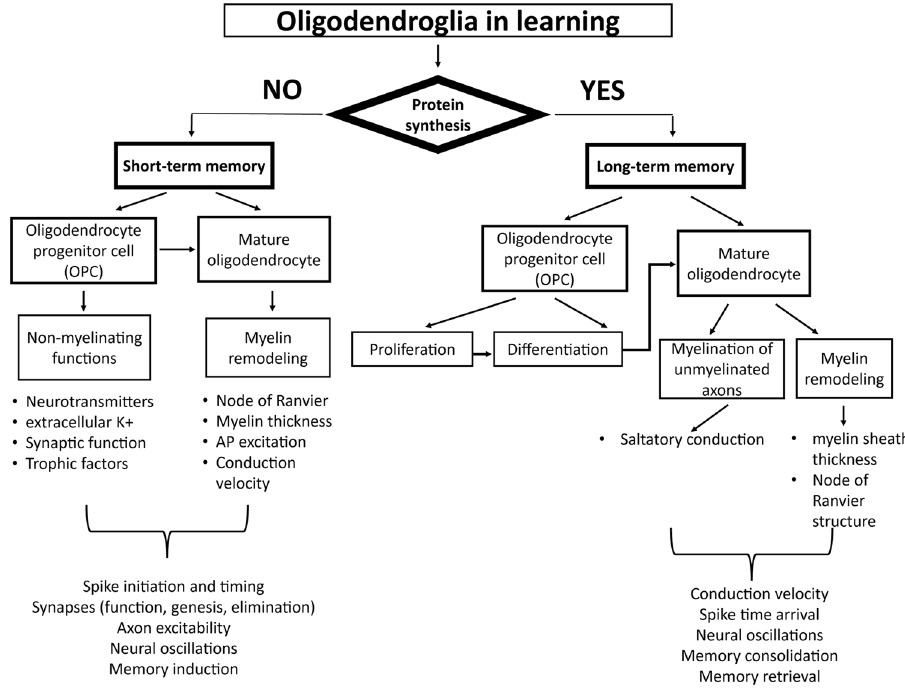
Fig. 4 Oligodendrocyte involvement in short-term memory, long-term memory, and memory consolidation. The distinguishing factor between short- and long-term memory is the necessity of protein synthesis for long-term memory. Oligodendrocytes participate in short-term memory via changes in pre- existing myelin and through non-myelinating functions of oligodendroglial cells rather than formation of new myelin. Non-myelinating functions of OL and OPCs includes control of extracellular K + concentration and regulating levels of neurotransmitters such as glutamate, essential for LTP and LTD. These changes affect axon excitability, and do not require protein synthesis. Activity-dependent initiation of myelination requires local protein synthesis (of myelin basic protein), indicating involvement of new myelin in long-term memory. Formation of new myelin and remodeling of mature myelin alter information processing and contributes to long-term memory. OPCs proliferate and differentiate into mature myelinating oligodendrocytes leading to new myelin sheath formation that contribute to remote memory consolidation by enhancing coupling among distance brain regions and within local circuits by optimizing spike time arrival and neural